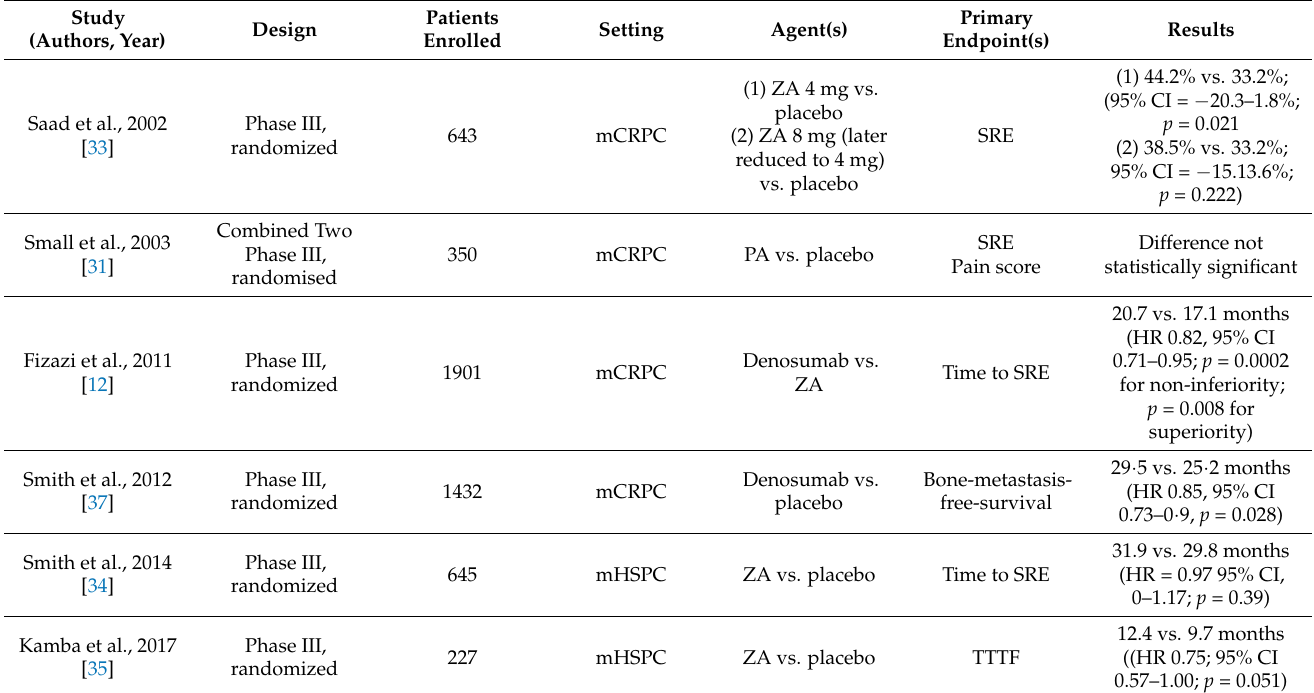
Table 1. Efficacy of Bone Targeting Agents in Prostate cancer: mCRPC = metastatic castration resistant prostate cancer; ZA = zoledronic acid, SRE = skeletal related events; PA = pamidronic acid; mHSPC = metastatic hormone sensitive prostate cancer; TTTG = time to treatment